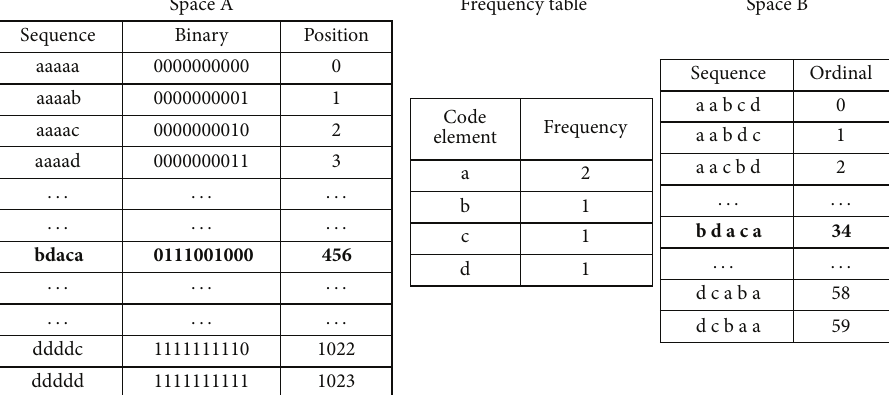
Figure 6: Space map under the benchmark sequence “abcd.”